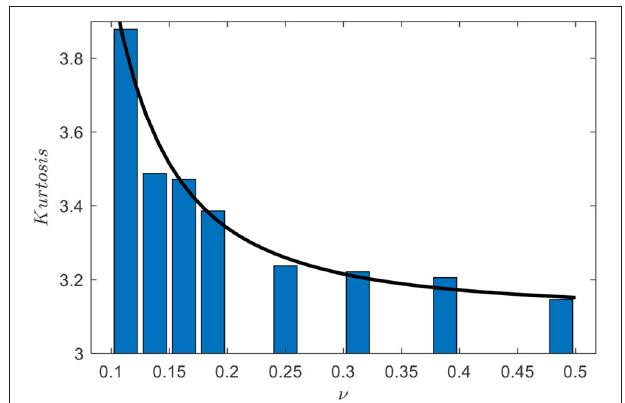
FIGURE 5 | Average kurtosis against spectral bandwidth. Bars represent the values estimated by using Eq. (1); Lines represent fitted results by Eq. (11). 0 for cases with =